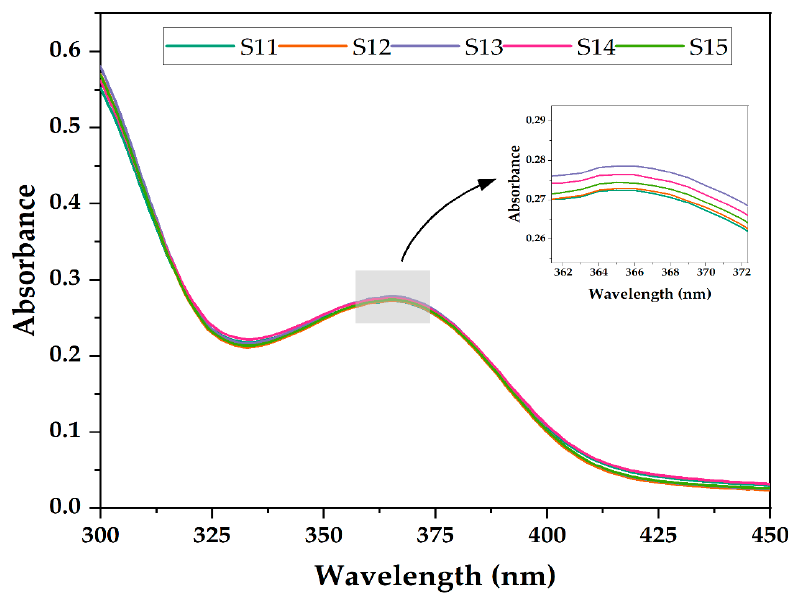
Figure 3. UV-Vis spectra of dissolved specimens of 10G/Alg/FA/Fe 3 O 4 . Insert: enlarged area of the spectra.